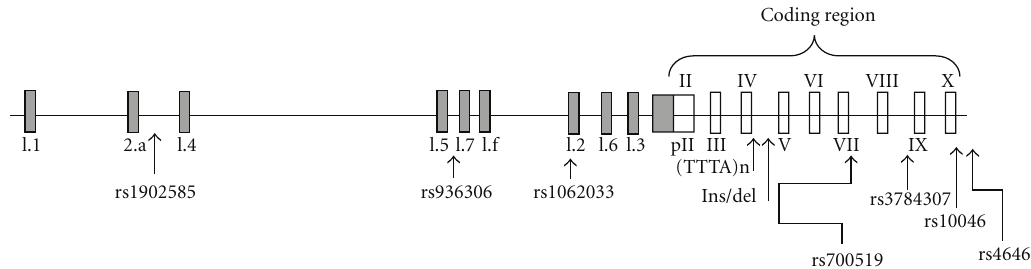
Figure 2: Aromatase gene ( CYP19A1 ) with its promoters and untranslated first exons. Major polymorphic variants of the CYP19A1 gene are